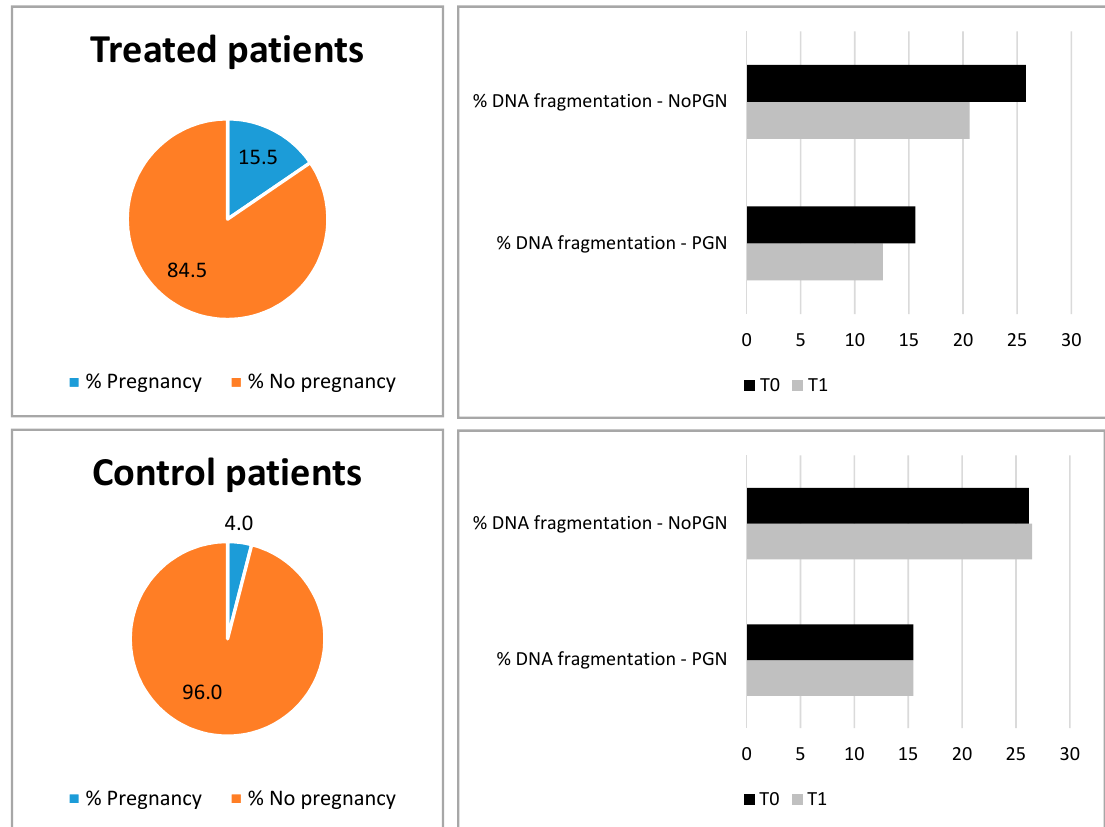
Figure 1. Pregnancy rate (% of couples at T1) of treated patients and control patients. DNA fragmentation observed (%) at T0 (black bars) and T1 (grey bars) in treated patients and control patient is reported, divided on the basis of positive or negative pregnancy outcome. PGN = pregnancy, NoPGN = no pregnancy.